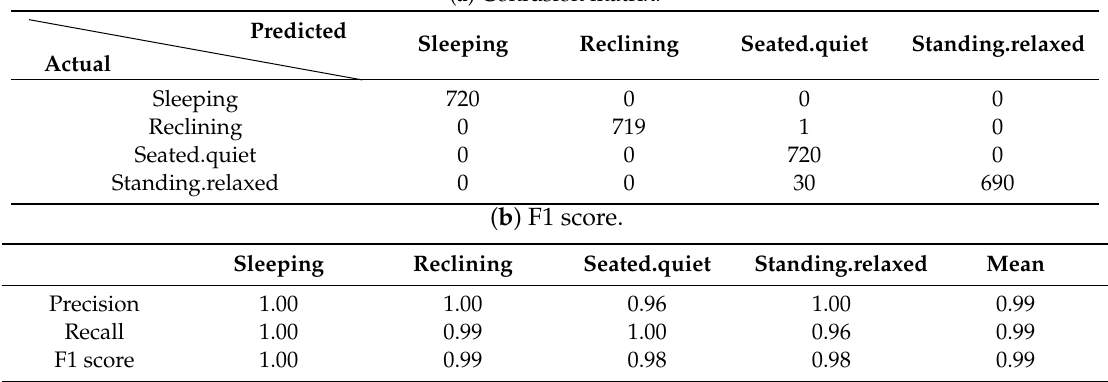
Table 2. Results for the real-time home-activity dataset. ( a ) Confusion matrix.